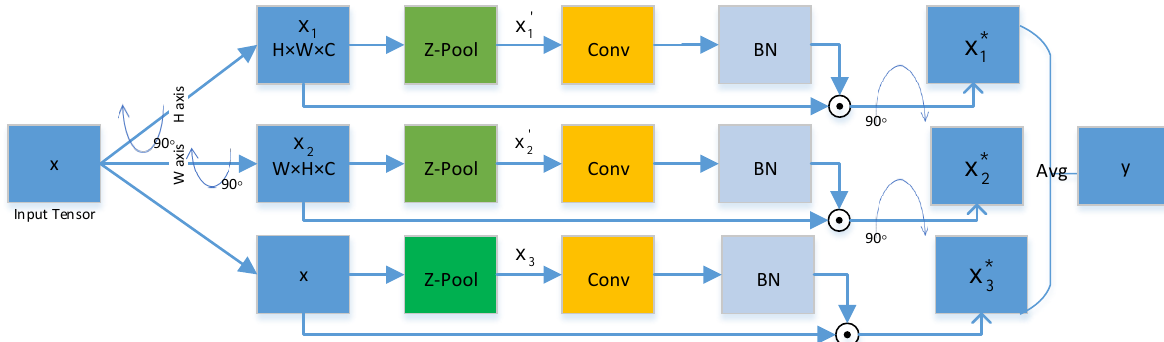
Figure 5. Illustration of the architecture of the convolutional triple attention module